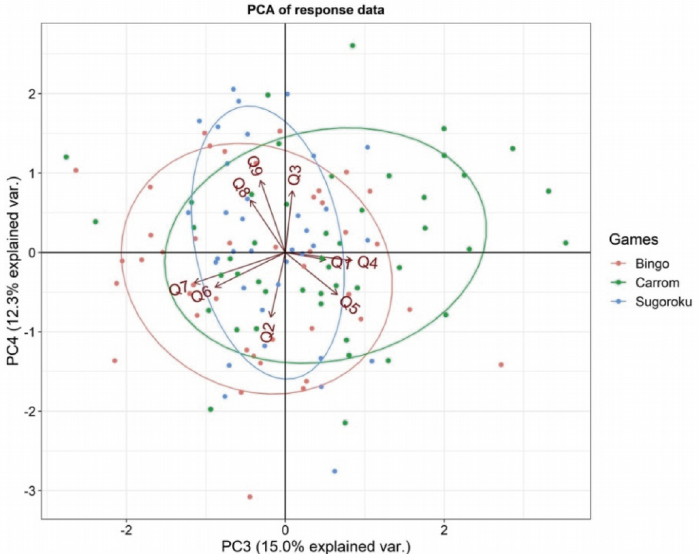
Figure S1. A bi-plot showing placement of responses from the participants as per the PCA components (PC3 and PC4, the other two PCs that results into 27 % variability in the participants response dataset) with respect to different questions after playing the games. Space components close to each other share similar